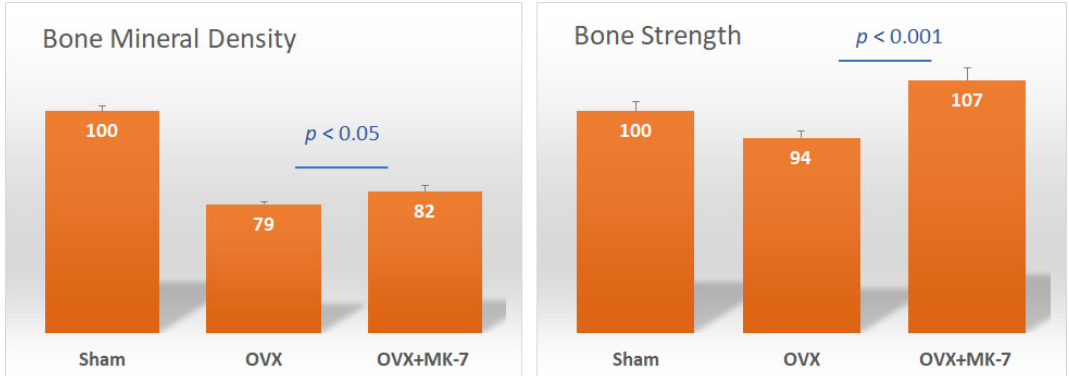
Figure 4. Effect of menaquinone-7 (MK-7) on bone mineral density (BMD) and bone strength of the femurs of ovariectomized rats. Sham: sham-operated group; OVX: ovariectomized rat control group; OVX + MK-7: ovariectomized rats that were fed MK-7. Data are expressed as relative values with the sham group taken as 100%. Adapted from [46].